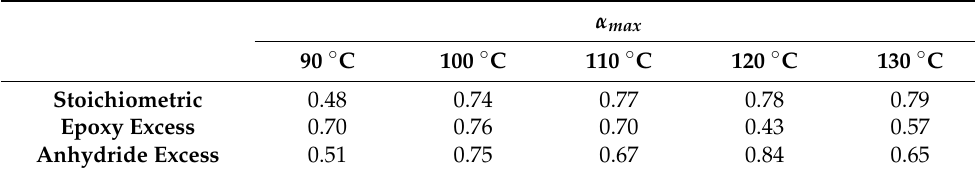
Table 3. Values of the maximum degree of cure α max reached after 2 h of isothermal DSC analysis for samples with different epoxy/anhydride ratios.